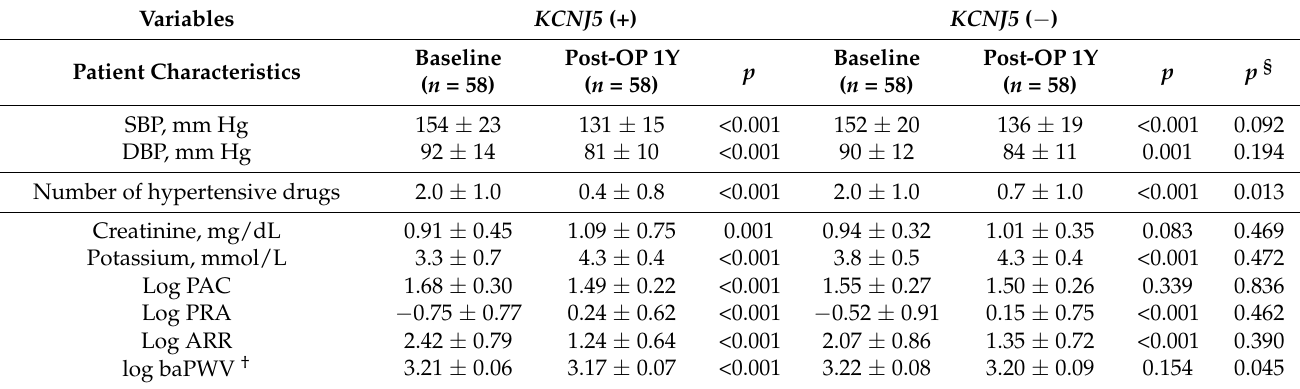
Table 4. Paired comparison of clinical data and pulse wave velocity data of matched * patients before and after adrenalectomy according to the status of KCNJ5